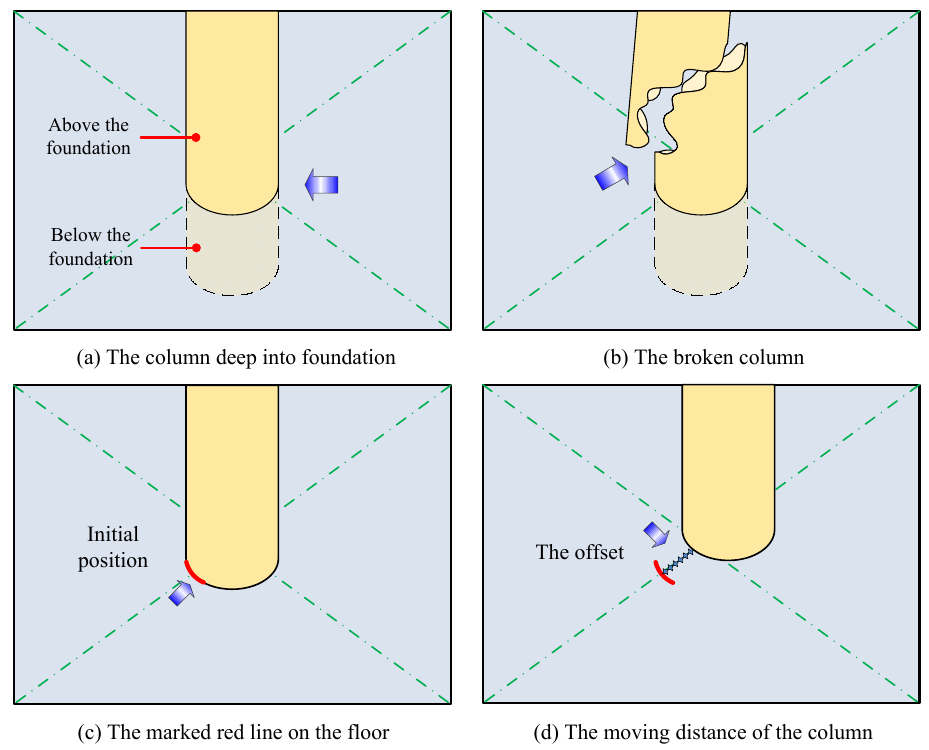
Figure 15. An earthquake resistance diagram of the columns of a scale model of the Forbidden City’s Shoukang Palace.